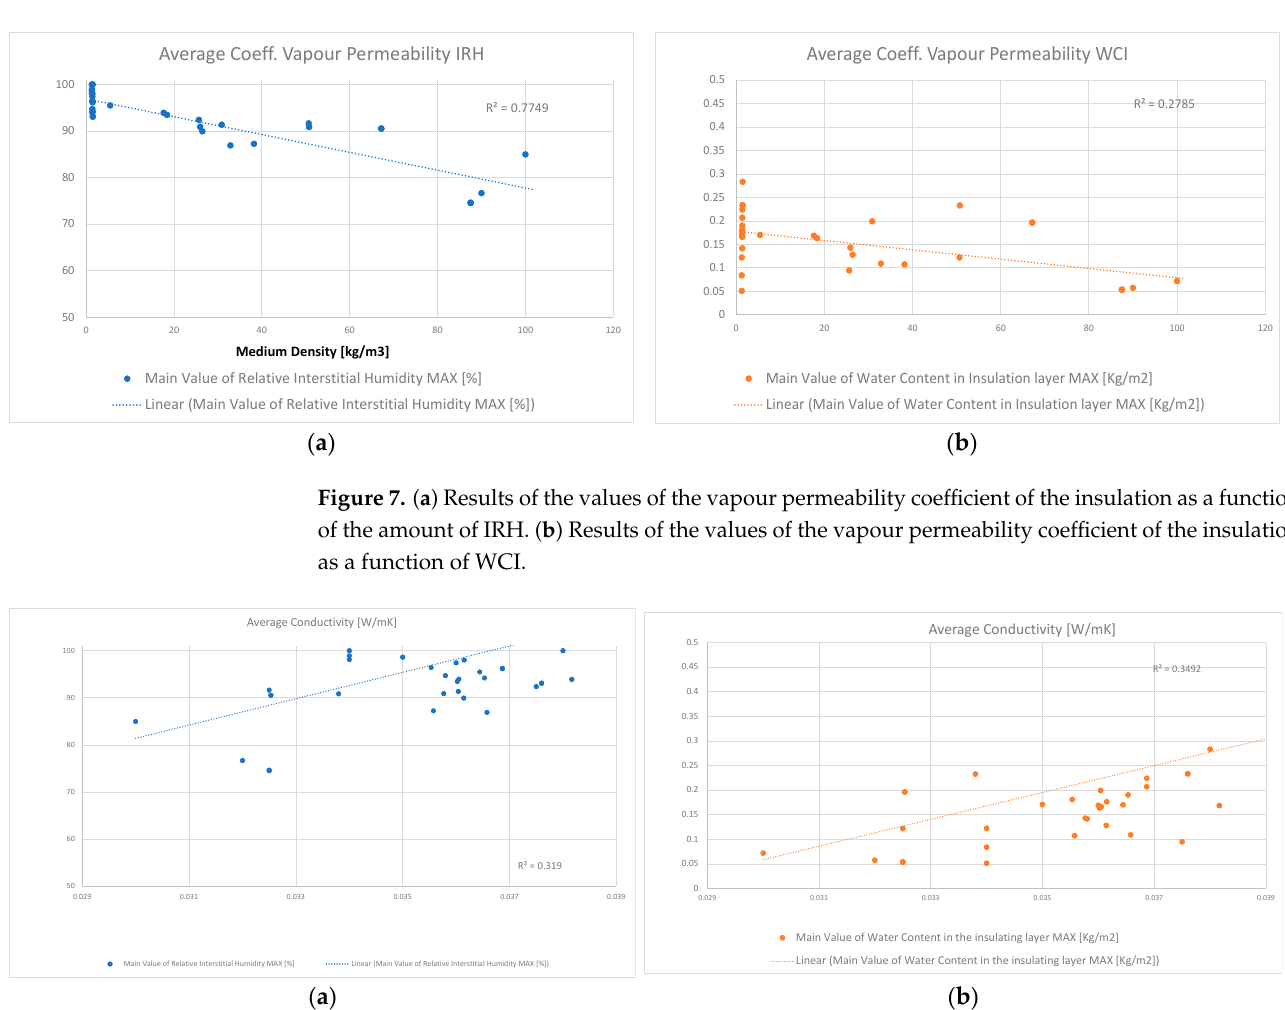
Figure 8. ( a ) Results of the conductivity values of the insulation as a function of the amount of IRH. ( b ) Results of the conductivity values of the insulation as a function of the amount of WCI.